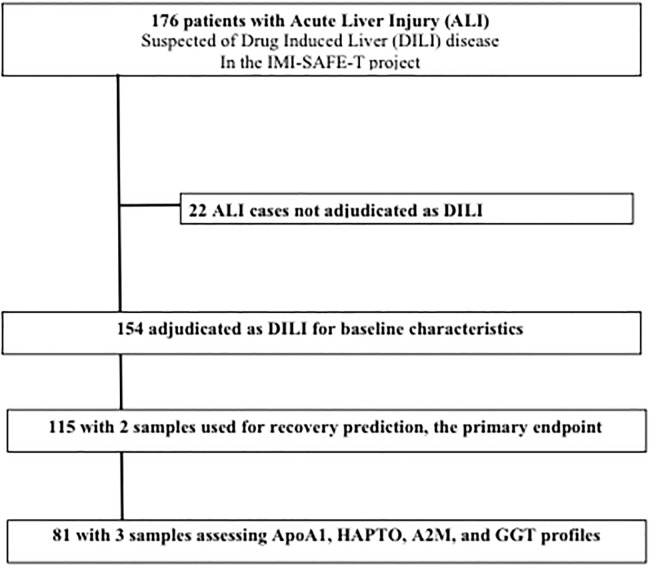
Flow chart of patients included and analyzed.